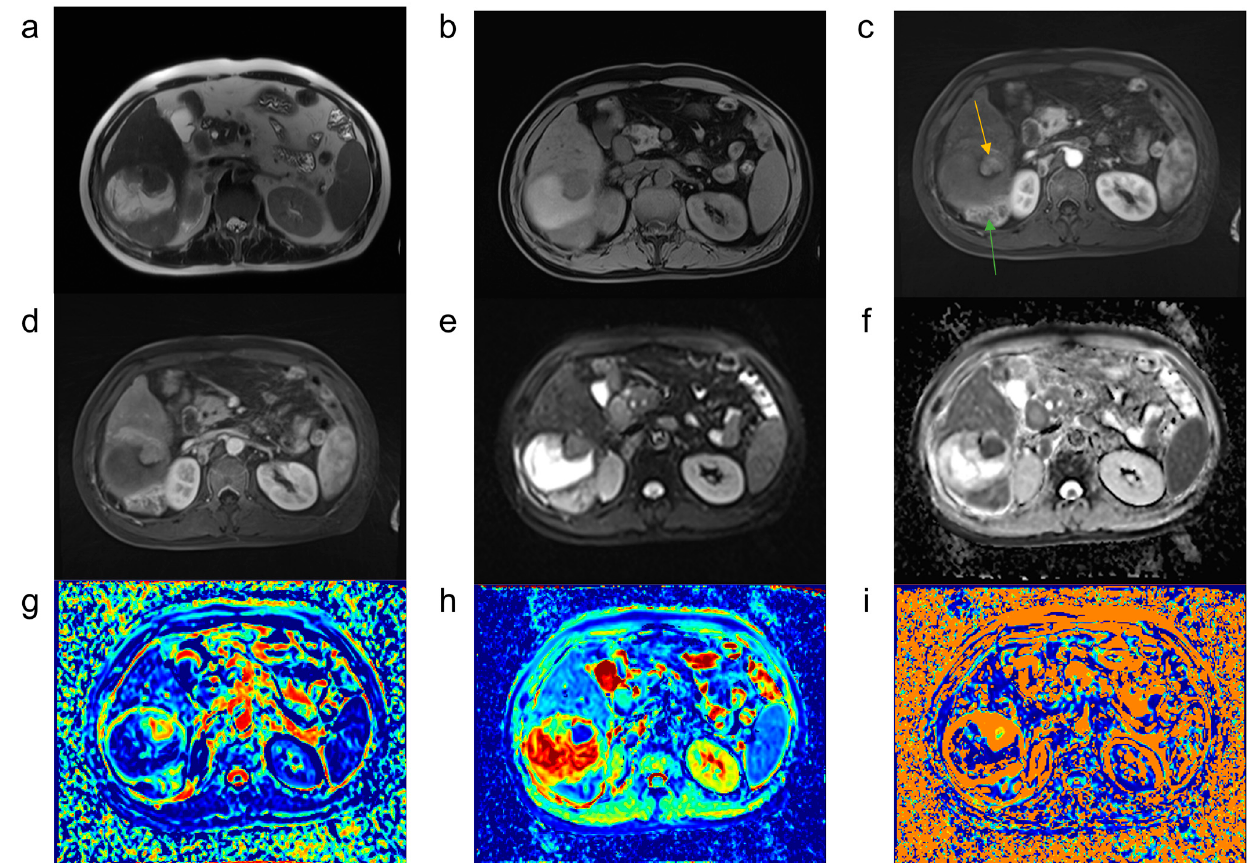
Figure 4. Magnetic resonance images of hepatocellular carcinoma treated using TACE. Most of the tumors after TACE treatment were necrotic, with the tumor active area (orange and green arrows) visible on the edge, which was significantly enhanced at the arterial phase, and the DWI image also showed a high signal intensity. ( a ) T2 ‐ weighted image; ( b ) T1 ‐ weighted image; ( c , d ) MR enhanced images; ( e ) diffusion ‐ weighted image with a b value of 0 s/mm 2 ; ( f ) ADC image; ( g – i ) parametric maps ( f , D, and D*, respectively) calculated from the IVIM.